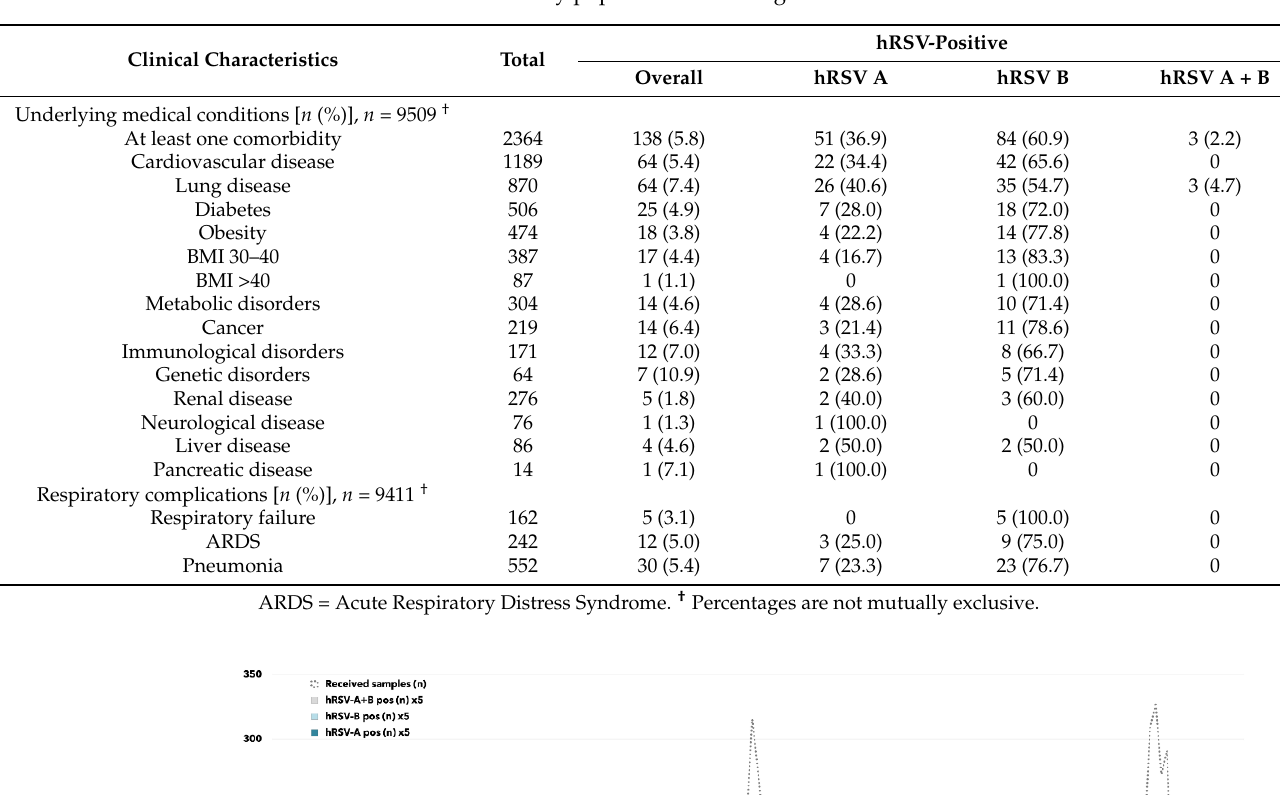
Table 2. Clinical characteristics of the study population according to hRSV detection. Period: 2015–2020. Clinical Characteristics